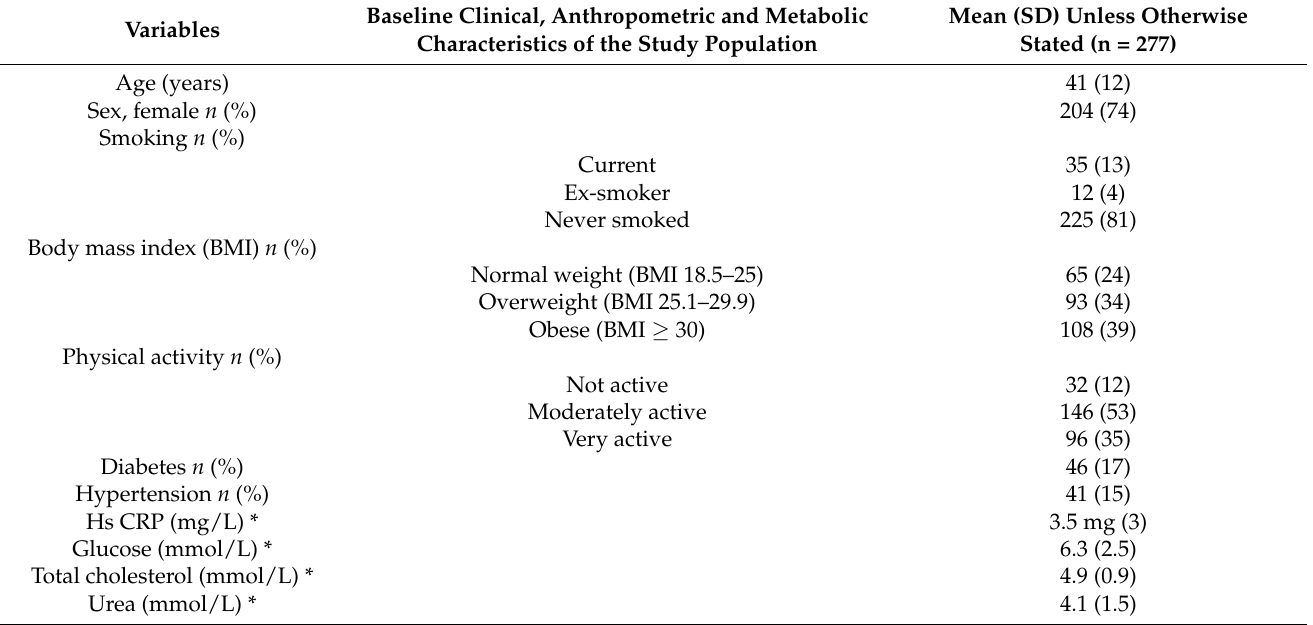
Table 1. Baseline clinical, anthropometric and metabolic characteristics of the study